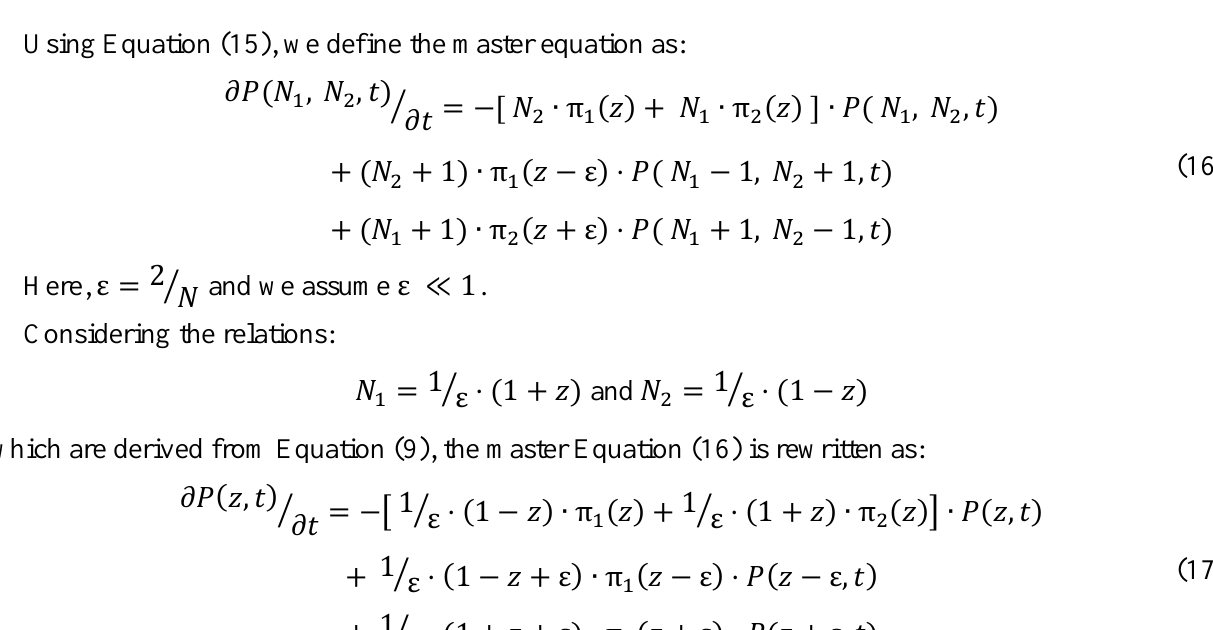
, 𝑁 ) and its adjacent states at time t 1 2